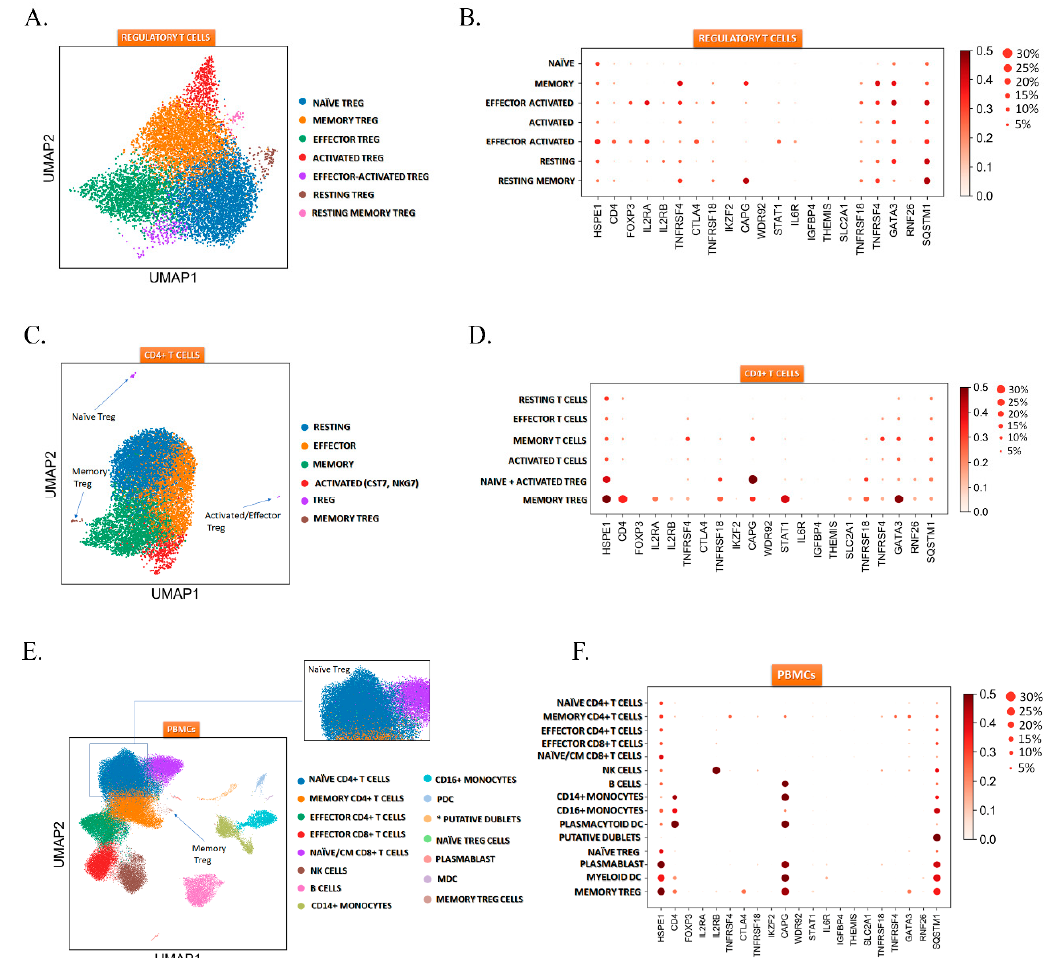
Figure 4. Regulatory T cell heterogeneity revealed by single cell transcriptomics. ( A ) UMAP clustering of T reg cells subsets. ( B ) T reg cell subtype dependent expression of HSPE1 . ( C ) UMAP clustering of CD4 + T cell subsets, blue arrows showing identified T reg cell subsets. ( D ) CD4 + T cell subsets dependent expression of HSPE1. ( E ) UMAP clustering of PBMCs, blue arrow showing memory T reg cell population and green points showing naïve T reg cell population dispersed in CD4 + naïve cells. ( F ) PBMCs subsets dependent expression of HSPE1.